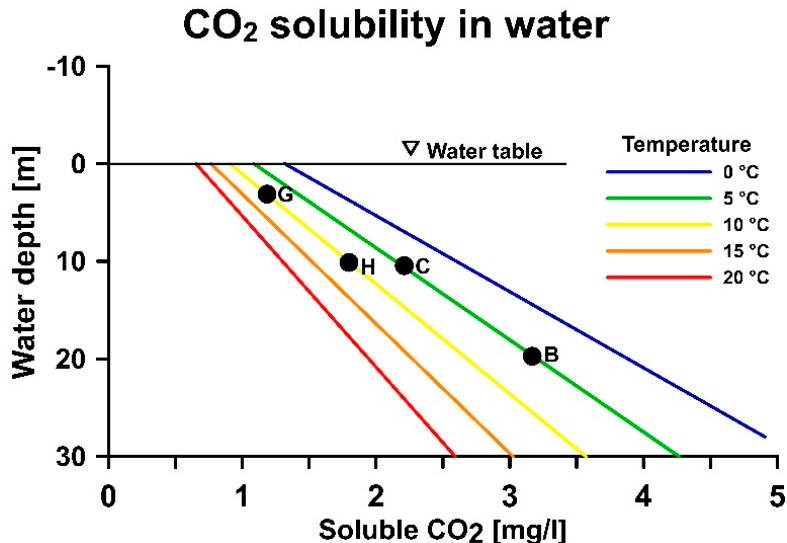
Figure 6. Degassing of CO 2 in the production well and the injection well associated with the traditional Norwegian GWHP design. The location of the screens ( B , H ), pump ( C ), and injection pipe ( G ) are plotted in the solubility regions for CO 2 , ref. Figure 4. Here, the GWHP system operates in a 5 °C cooling mode.